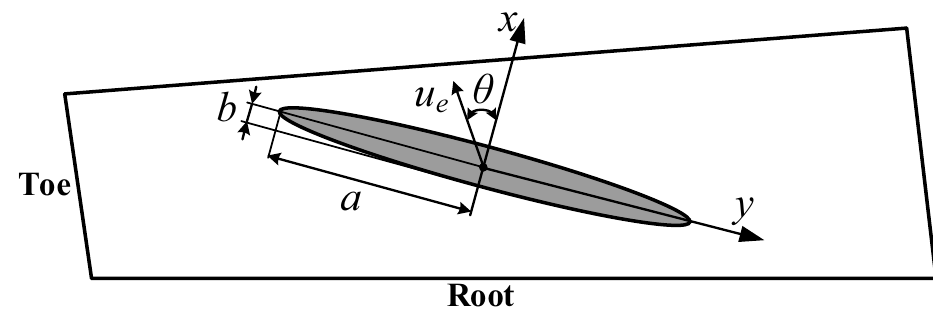
Figure 1. Schematic diagram of the angle θ between the lubricant entrainment and the minor axis of the contact